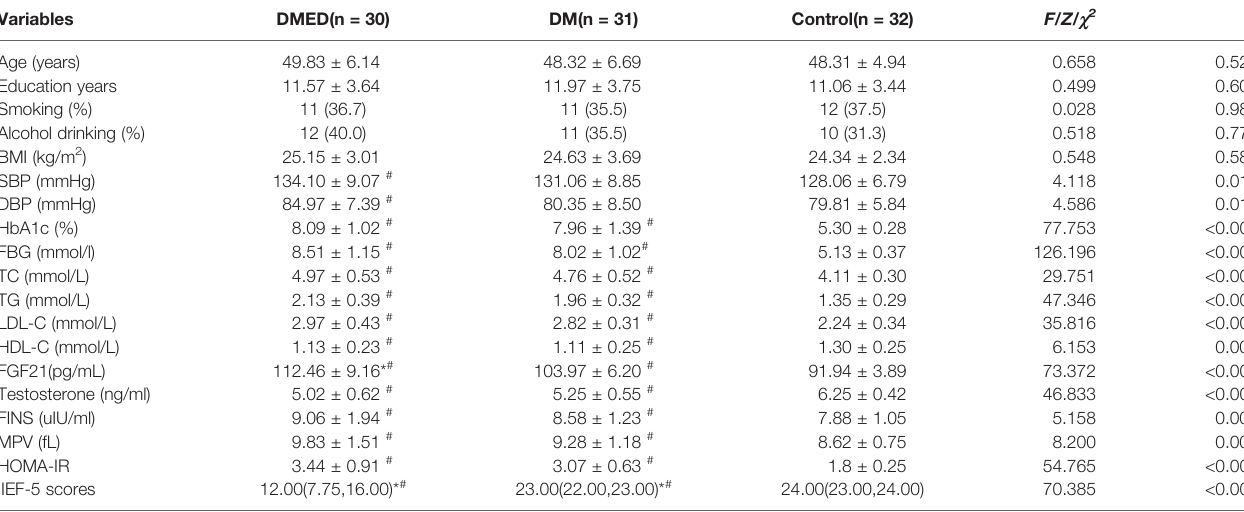
TABLE 1 | Characteristics of study participants in human study.